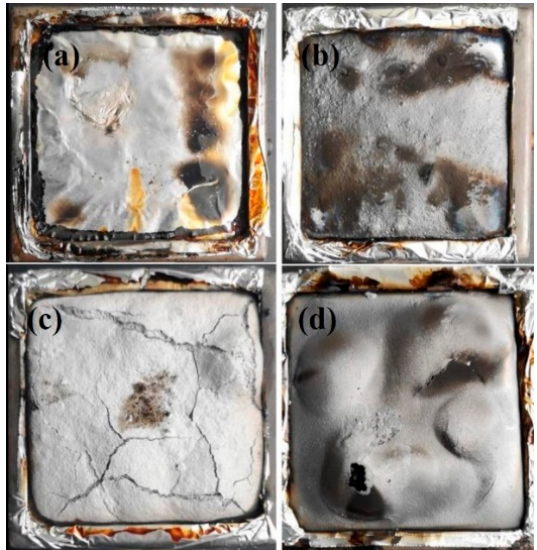
Figure 5. The digital photographs of the residues at a flux of 35 kW m − 2 . ( a ) EVA0; ( b ) EVA1; ( c ) EVA2; ( d ) EVA5.